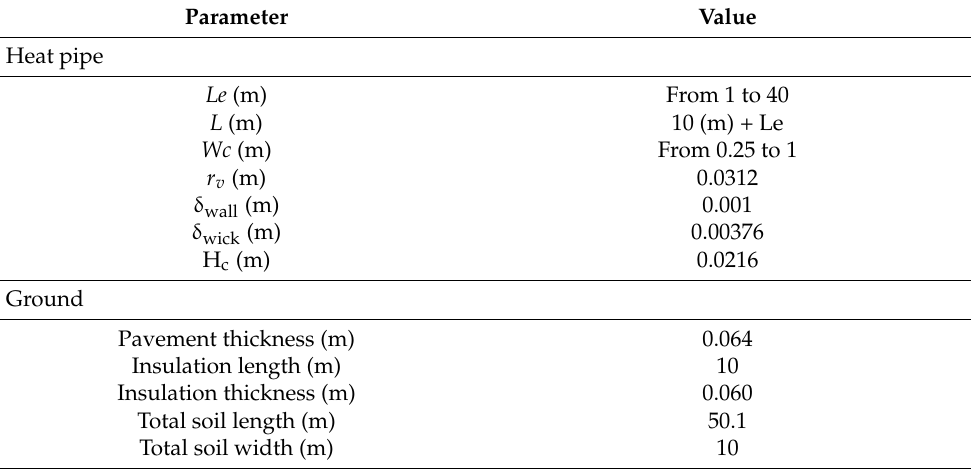
Table 2. Dimension of heat pipe and ground.